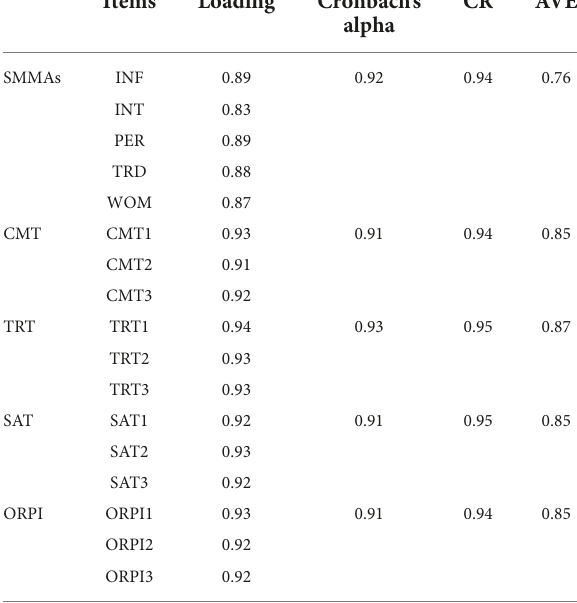
TABLE 2 Constructs loading, Cronbach’s Alpha, CR, and AVE values.